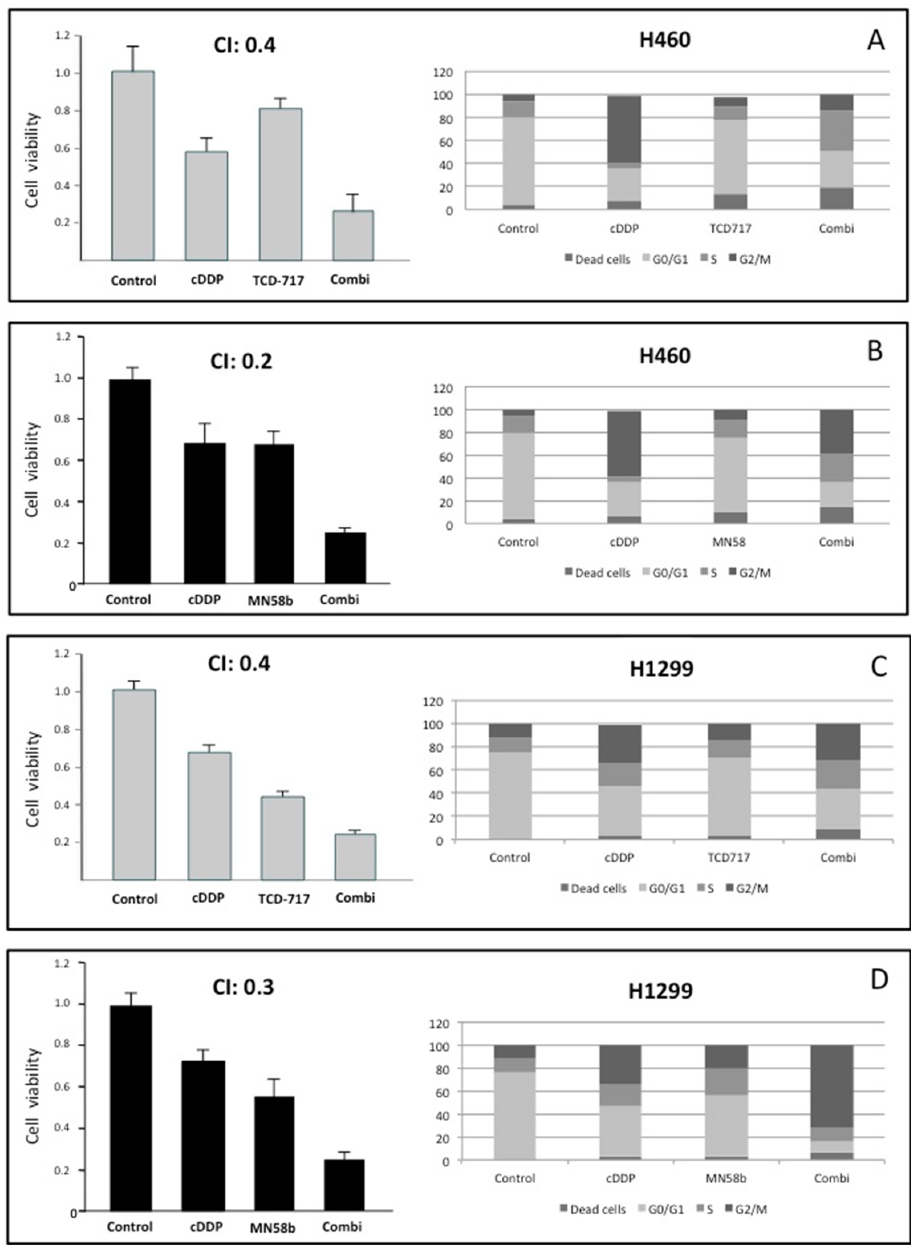
Figure 2. Synergistic effect of ChoK α inhibitors and cisplatin in H460 and H1299 cells. ( A , B ) H460 cells were exposed to cisplatin for 5 h. Then, cells were treated with RSM-932A/TCD-717 ( A ) or MN58b ( B ) for 40 h. Cytotoxicity was evaluated by MTT assay (left panels). Combinations of the two drugs was also tested using flow cytometry analysis (right panels). ( C , D ) H1299 cells were treated as indicated for H460 cells with either RSM932A/TCD-717 ( C ) or MN58b ( D ). Represented CI value in each case is the mean of three independent experiments for each concentration in quadruplicate. As shown for both drugs, a CI < 1 indicated a strong synergistic effect. Furthermore, combination of the two drugs increased cell death compared to the two drugs alone, as determined by flow cytometry analysis. As shown, similar results were obtained with both cell lines.